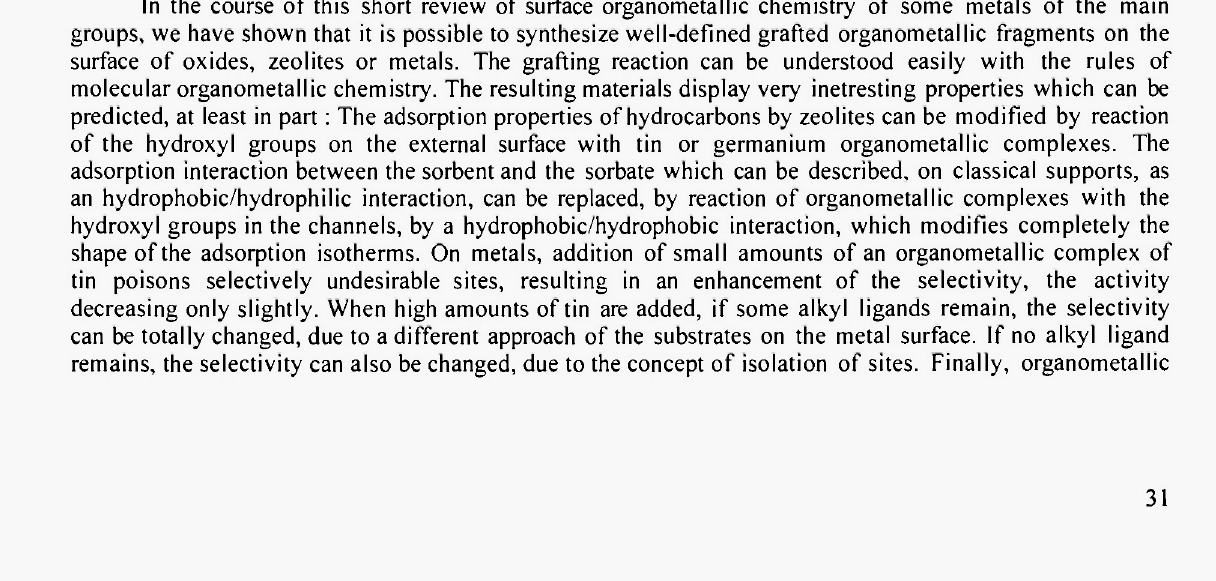
Figure 15 : Amount of sorbed arsenic as a function of time and X-ray diffraction powder spectra of some